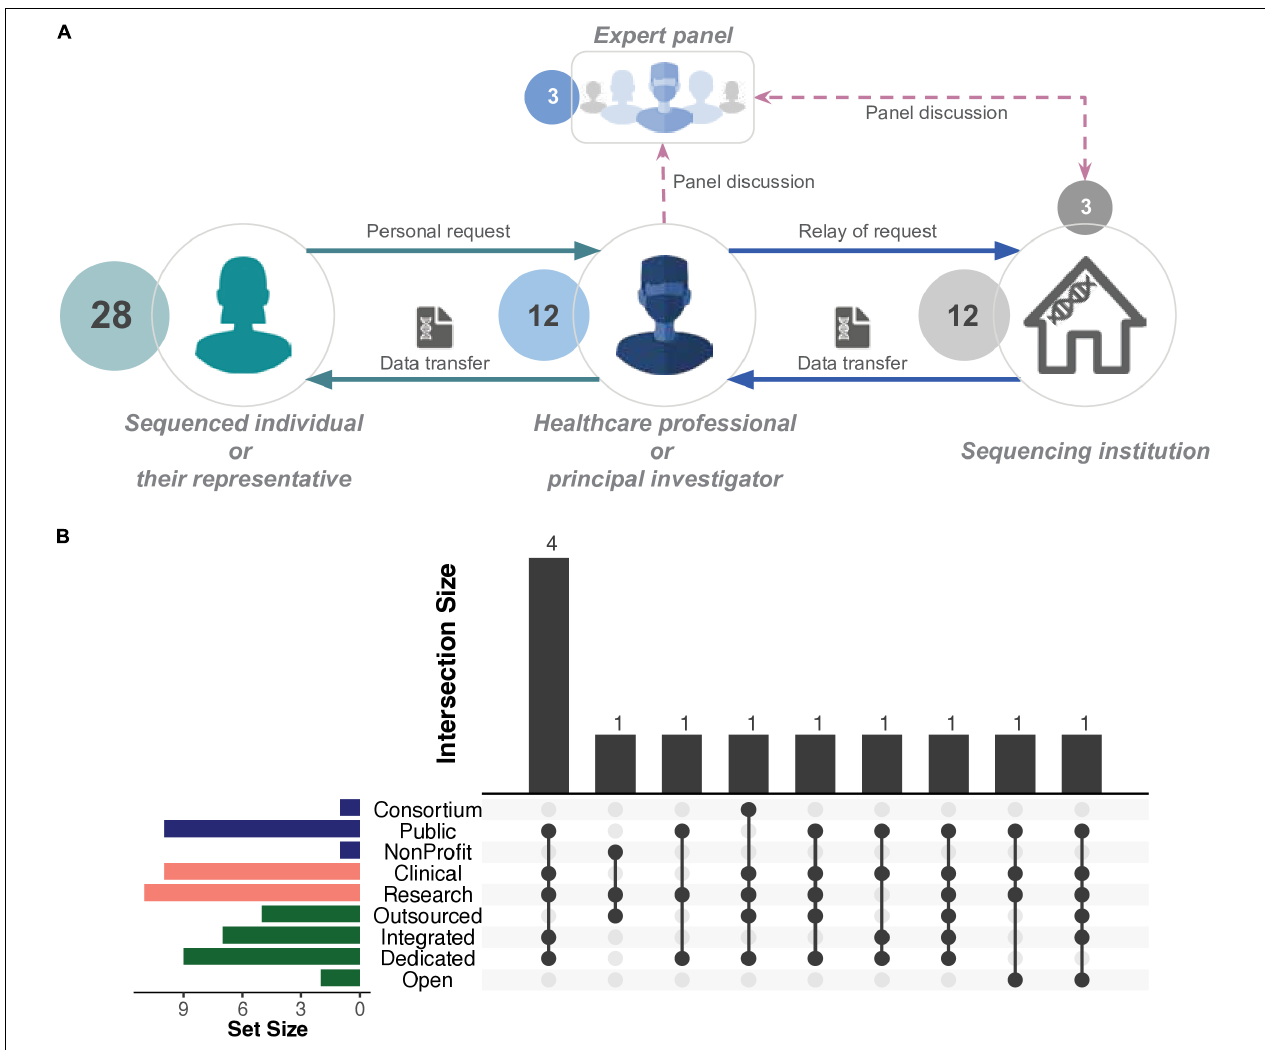
FIGURE 4 | Generalised illustration of access in practice. (A) Typical scenario of personal whole genome (WGS) or whole exome (WES) sequencing data access. Individuals request their data through a healthcare professional or a principal investigator. Those parties authorise the access to the genomic data. In certain cases, a panel of experts, which may include personnel from a sequencing institution, jointly decide and authorise the access. The final decision is relayed to the sequencing institution, which initiates the data transfer process, mediated by a healthcare professional or principal investigator. Sequenced individuals do not directly interact with the sequencing institution. For detailed descriptions, refer to Table 1 . (B) UpSet plot (Conway et al., 2017) represents the number and types of sequencing institutions that successfully enabled personal access to raw genomic data of patients and/or research participants. The horizontal bars represent the elements of organisational structure, purpose of sequencing, and operational model ( Figure 1 ). The bottom panel represents the intersections between the aforementioned elements. The vertical bars represent the size of those intersections. Detailed information available in Supplementary File 2: Tables S2, S6